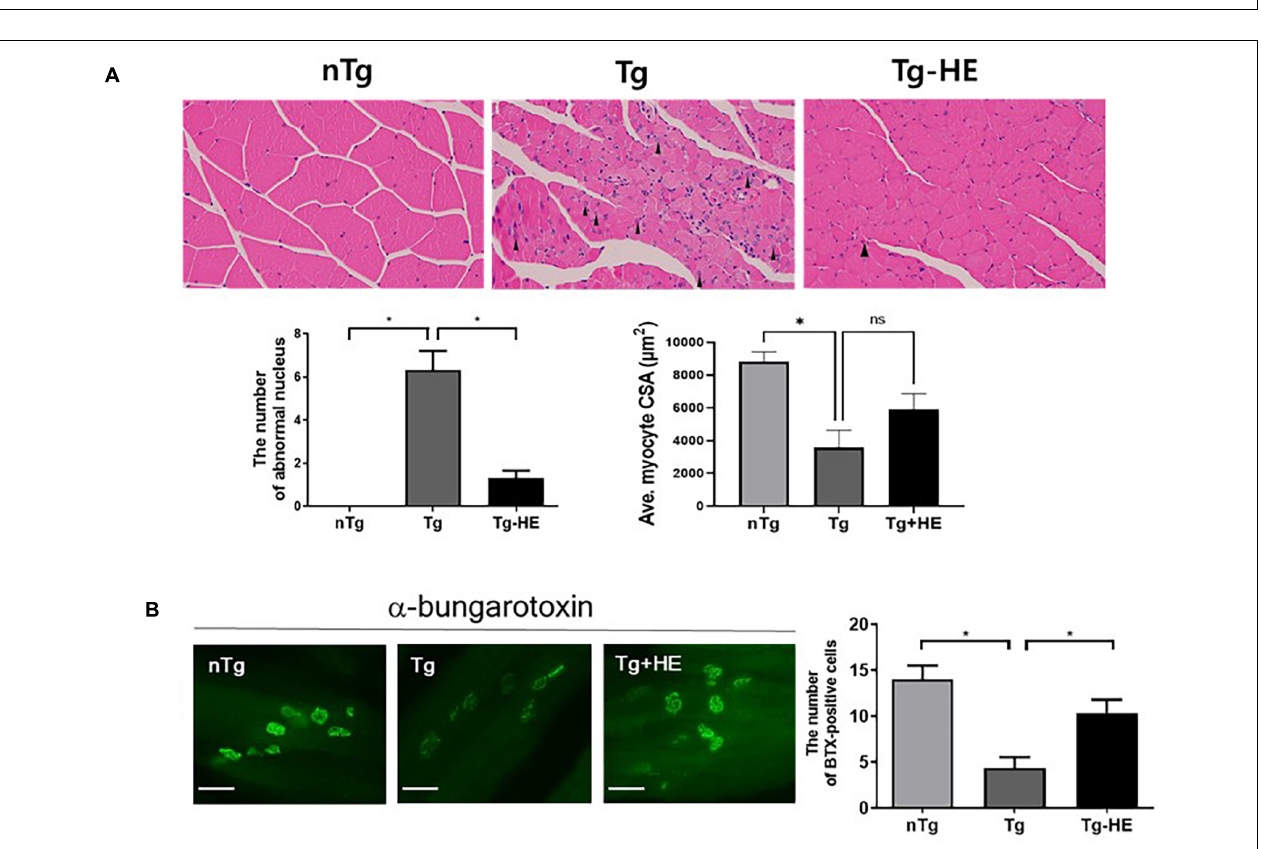
FIGURE 4 | Herbal extract (HE) regulates autophagy dysfunction in the gastrocnemius (GC) of hSOD1 G93A mice. (A) GC is immunoblotted with p62 and LC3b using nTg, Tg, and Tg-HE ( N = 3). (B) Protein expression is quantified relative to the expression of actin, which was used as loading control. Data are shown as the mean ± SEM. The statistical analyses were conducted with a one-way ANOVA followed by Bonferroni’s multiple comparison tests (** p < 0.01 and *** p < 0.001).